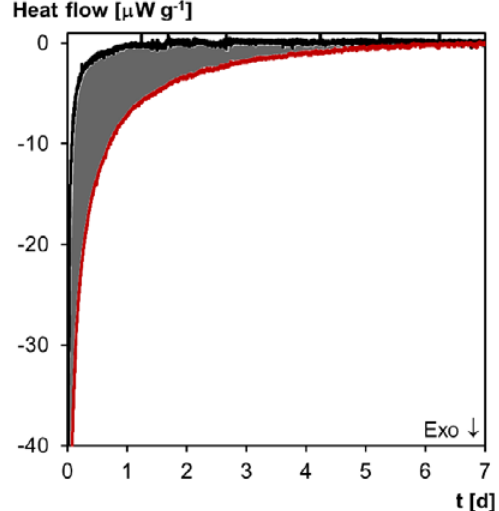
Figure 15. Microcalorimetry of 3M ‐ F375PMA. Normalized heat flow as a function of time at 20 °C. Black line : undamaged film sample; Red line : compressed fresh powder; Grey area : Diels–Alder reaction enthalpy of fresh powder.